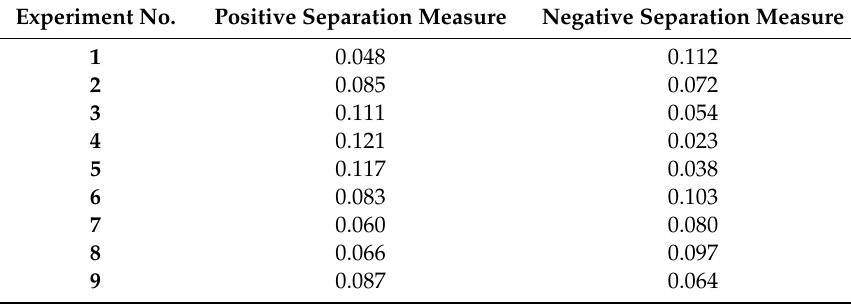
Table 7. Values of positive and negative separation measure.